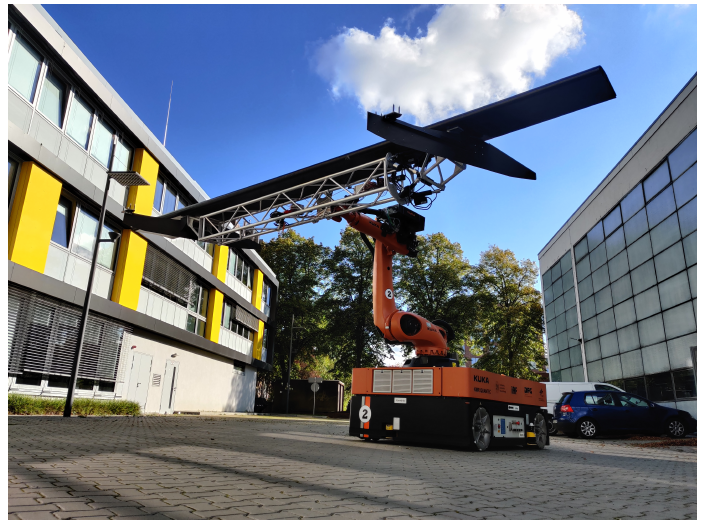
Figure 18. Mobile robot holding the flap in assembly